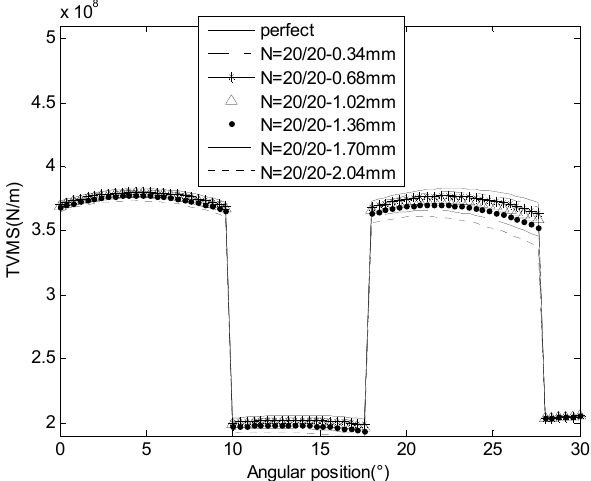
Figure 23. Meshing stiffness for the cracked gear under tooth number 20/20.